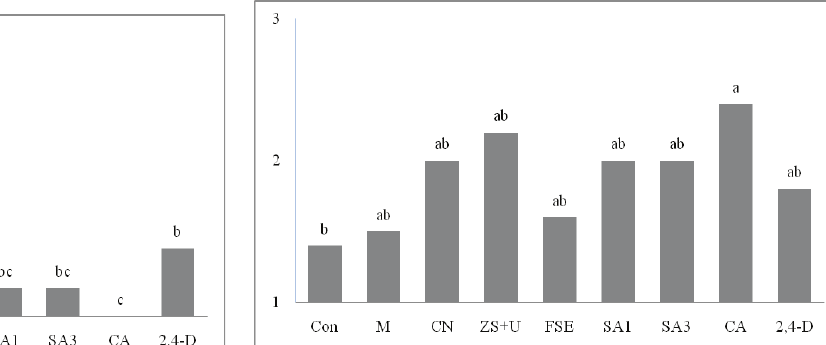
Figure 3: Effect of foliar-applied methanol (M), calcium nitrate (CN), zinc sulfate + urea (ZS+U), fermented sugarcane extract (FSE), salicylic acid 1 and 3 mM (SA1 and SA3), citric acid (CA), 2,4-dichlo- rophenoxyacetic acid (2,4-D) and water (Con) on fruit decay (%) of ‘Thompson Navel’ orange. Differences in column headings denote statistically significant treatment effects (P< 0.01)